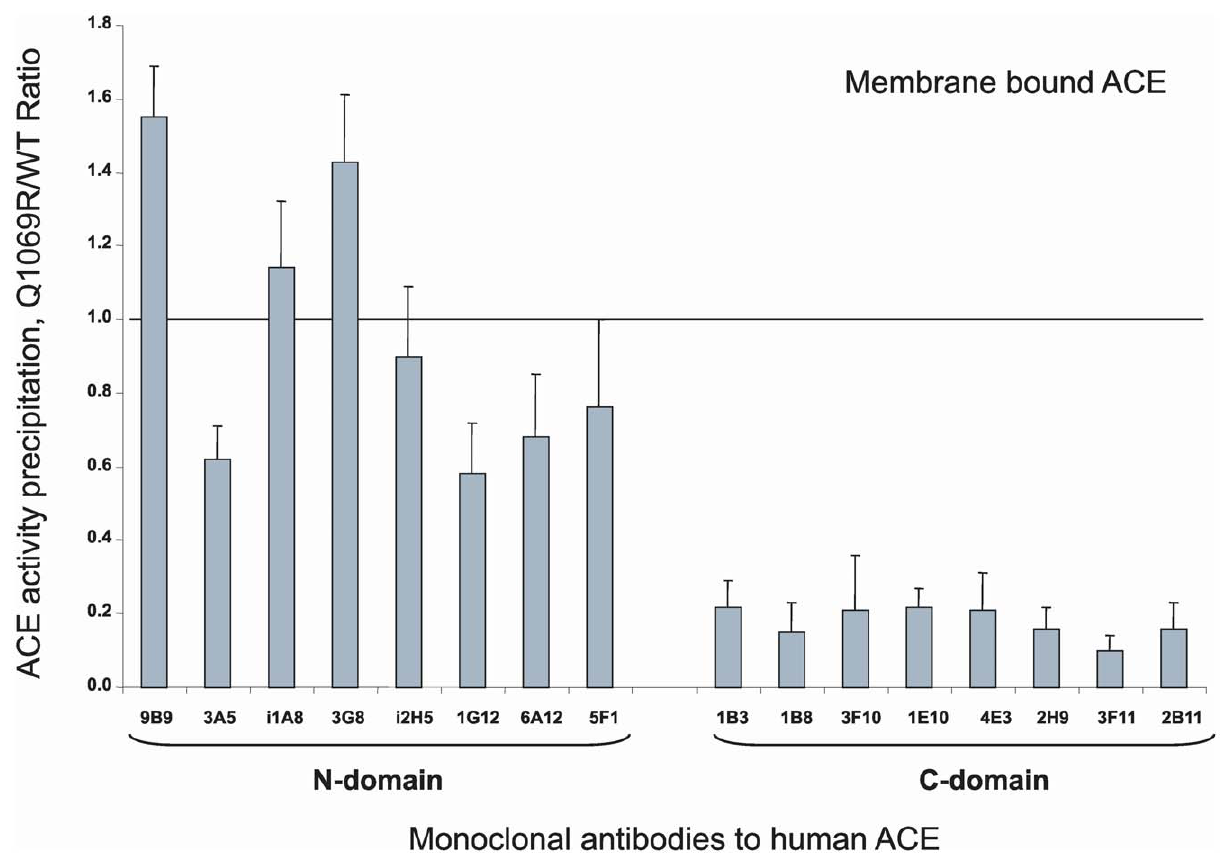
Figure 7. Conformational fingerprinting of mutant ACE. Membrane-bound WT and mutant ACE lysates were normalized to achieve 5 mU/ml ACE activity with Z-Phe-His-Leu as substrate and incubated in microtiter plate wells covered with 16 mAbs to human ACE [16,30] via goat-anti-mouse IgG. Precipitated ACE activity was quantified by fluorimetric plate precipitation assay [30,54]. Data (mean 6 SD of 6–8 independent experiments in duplicate) are expressed as ratio of ACE activity precipitated by mAbs from mutant ACE to that of WT ACE. * p , 0.05 vs. WT ACE.